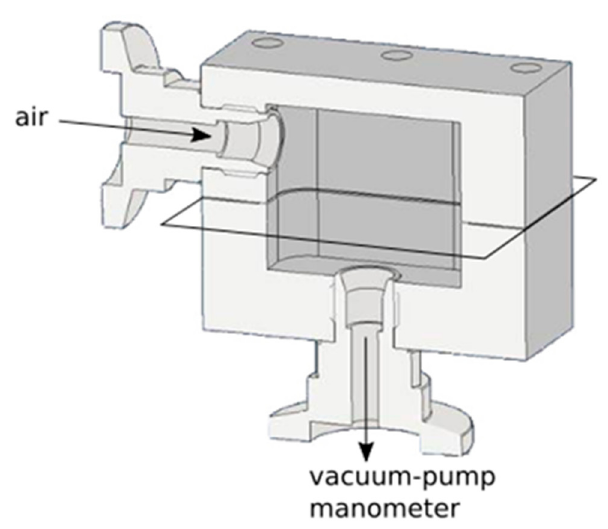
Figure 1. Experimental setup for gas permeability measurements. A foil (black outlines) is placed between two hollow metal blocks. One side (top) is open to the environment, the other (bottom) is connected to a vacuum pump and a manometer. The pump can be sealed off with a valve. Gas barrier properties are determined by reducing the pressure on the bottom side to 400 mbar and then recording the rise in pressure